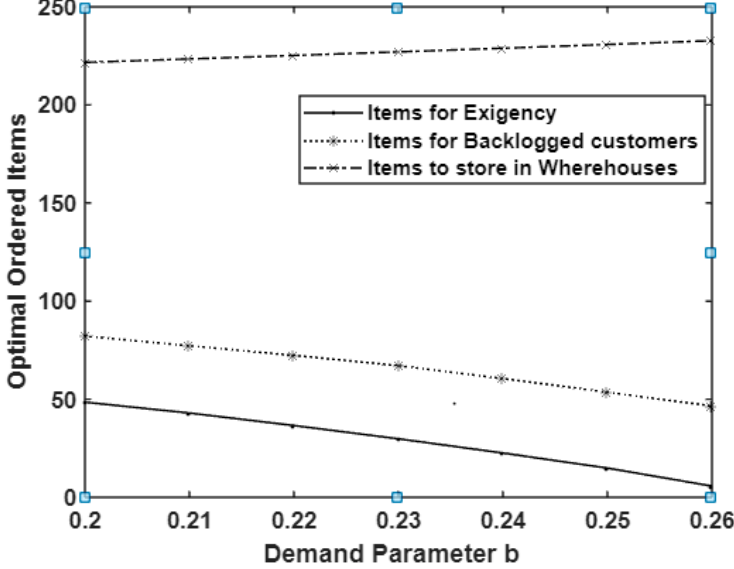
Figure 5. The effect of changes in demand parameter 𝒷 on optimal ordering items.